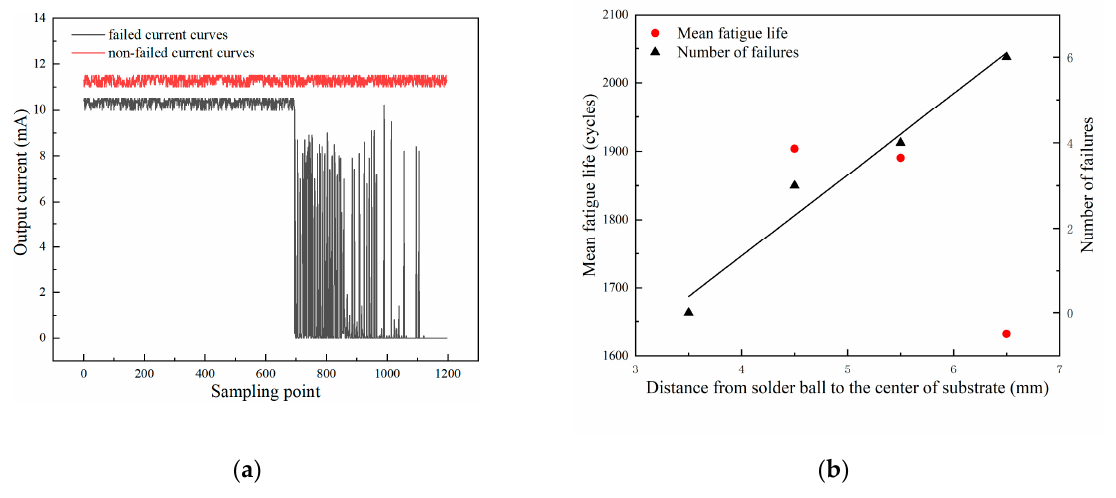
Figure 3. ( a ) Typical failed and non-failed current curves. ( b ) Results of thermal fatigue